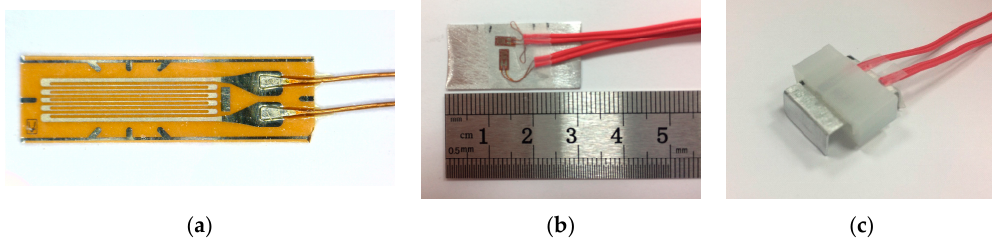
Figure 2. Strain gauge and 3D-printed tunnel-shaped protection device, ( a ) strain gauge; ( b ) pasting design for temperature error calibration; ( c ) tunneling encapsulation.